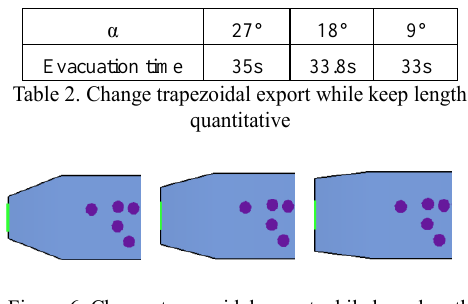
Figure 6. Change trapezoidal export while keep length quantitative